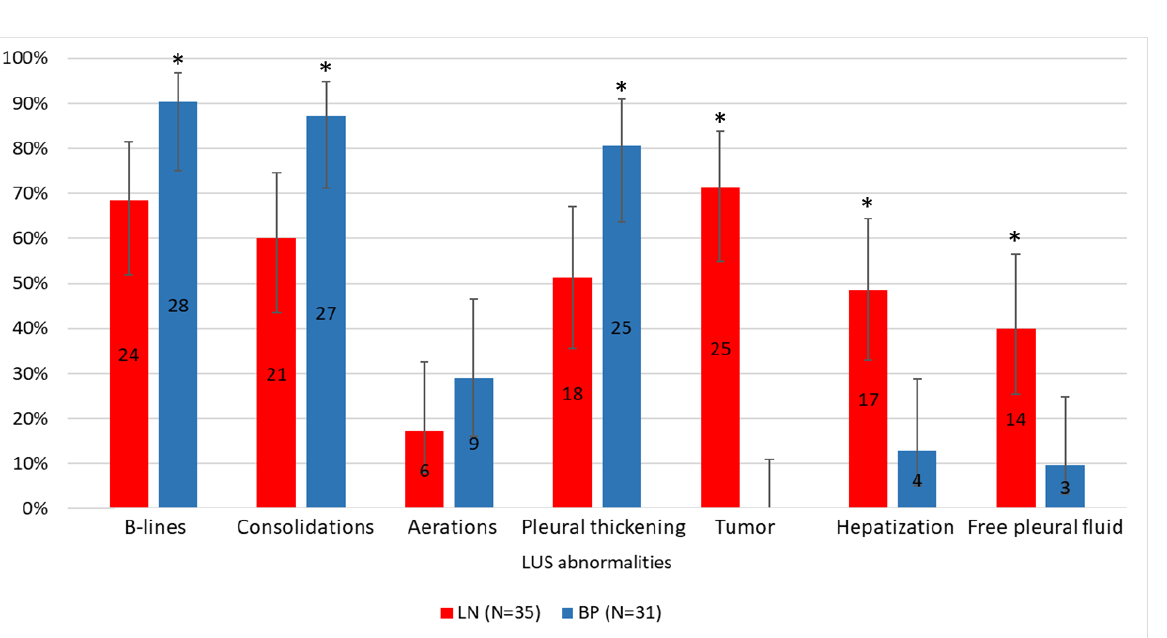
Figure 13. Distribution of lung ultrasound (LUS) abnormalities in dogs with lung neoplasm (LN) and bacterial pneumonia (BP). The number of dogs with a given LUS abnormality in a group is presented in the center of each bar. Whiskers correspond to the 95% confidence interval (CI 95%). Asterisks (*) indicate a group with significantly higher prevalence of a given LUS abnormality according to the maximum likelihood G-test.